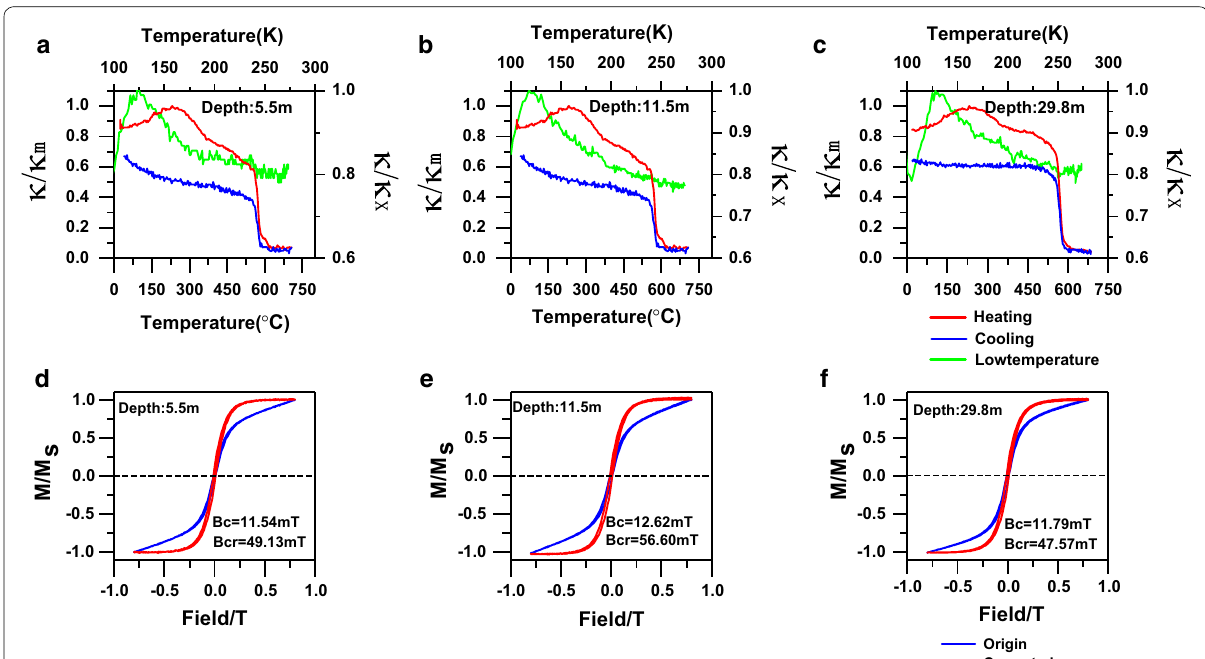
Fig. 2 a – c κ–T curves of representative samples (green line indicates the low-temperature susceptibility, while red and blues lines represent heat- ing and cooling runs, respectively); d – f hysteresis loops of the same samples (blue lines are original data, and red lines are obtained after slope correction)